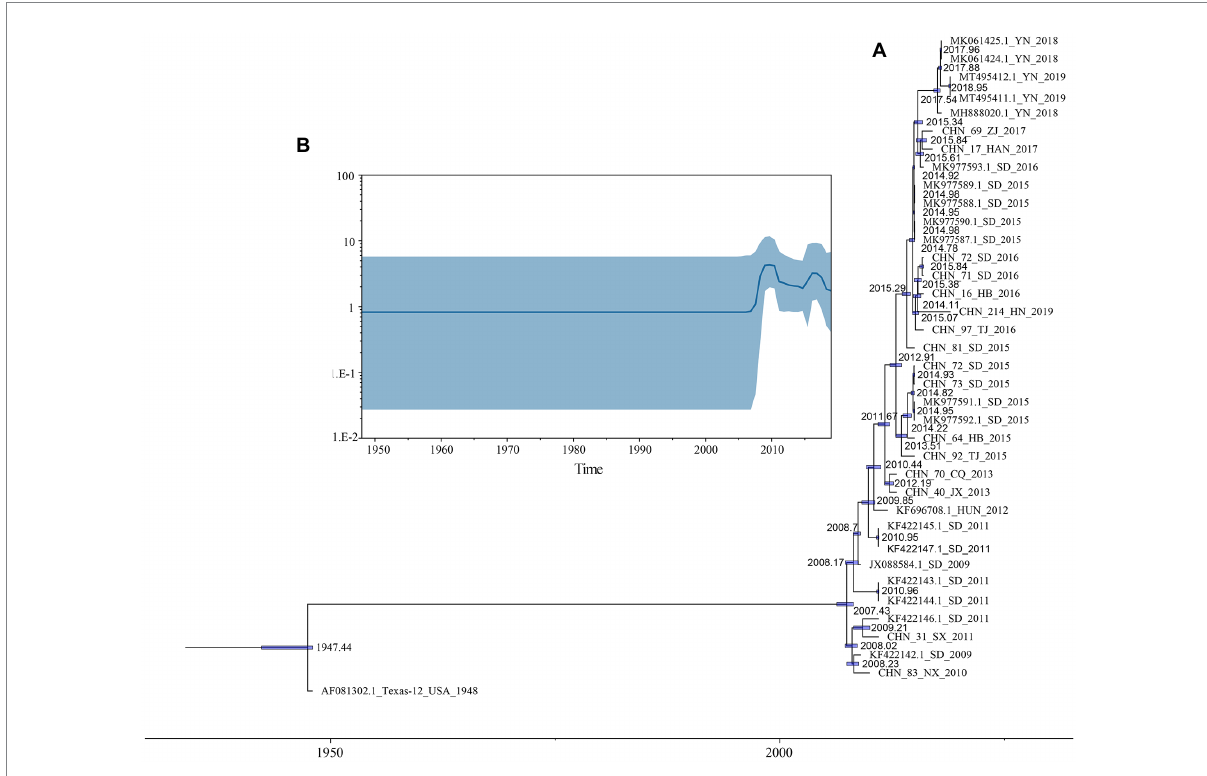
FIGURE 2 (A) A phylogenetic tree with Maximum Clade Credibility (MCC) was constructed based on the full-length VP1 sequences of CVA12 in GenBank and 16 CVA12 sequences from this study. The blue bar represents 95% HPDs of tMRCAs. (B) A Bayesian skyline plot based on the full-length VP1 sequences of CVA12 reflects the effective population size in mainland China from 2009 to